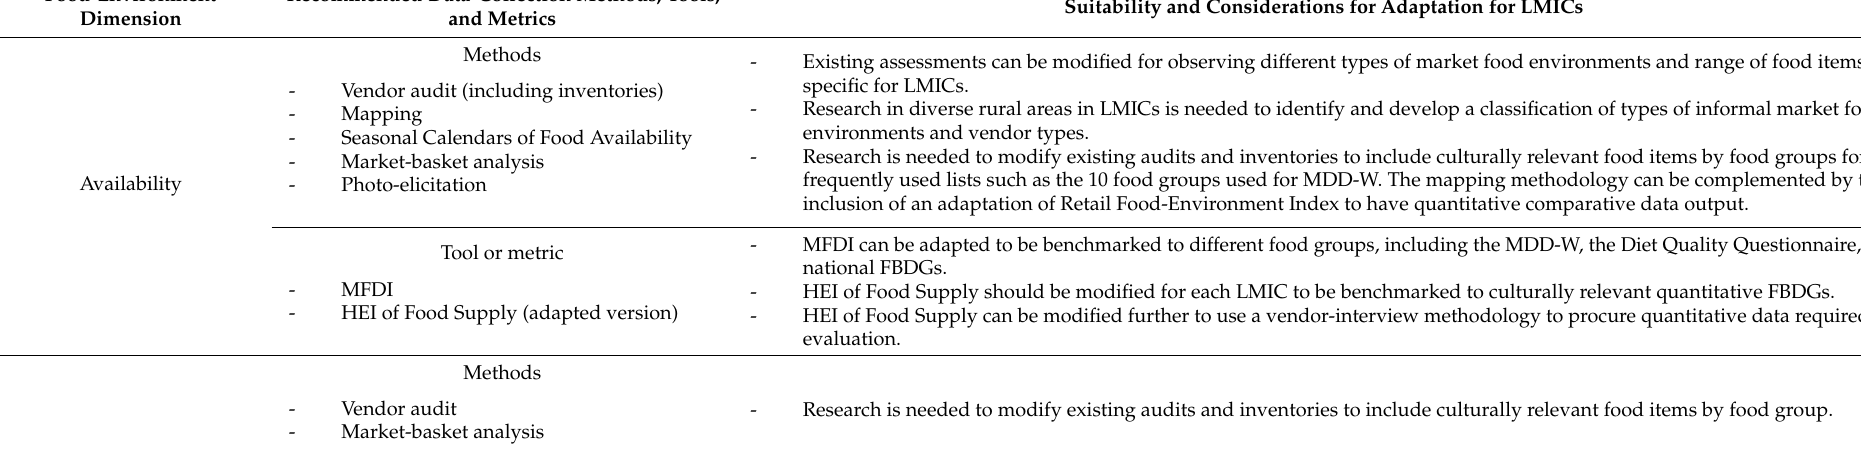
Table 3. Recommended Assessments and Considerations to Adapt Data-Collection Methods, Tools, and Metrics for Informal Market Food Environments in LMICs. Food-Environment